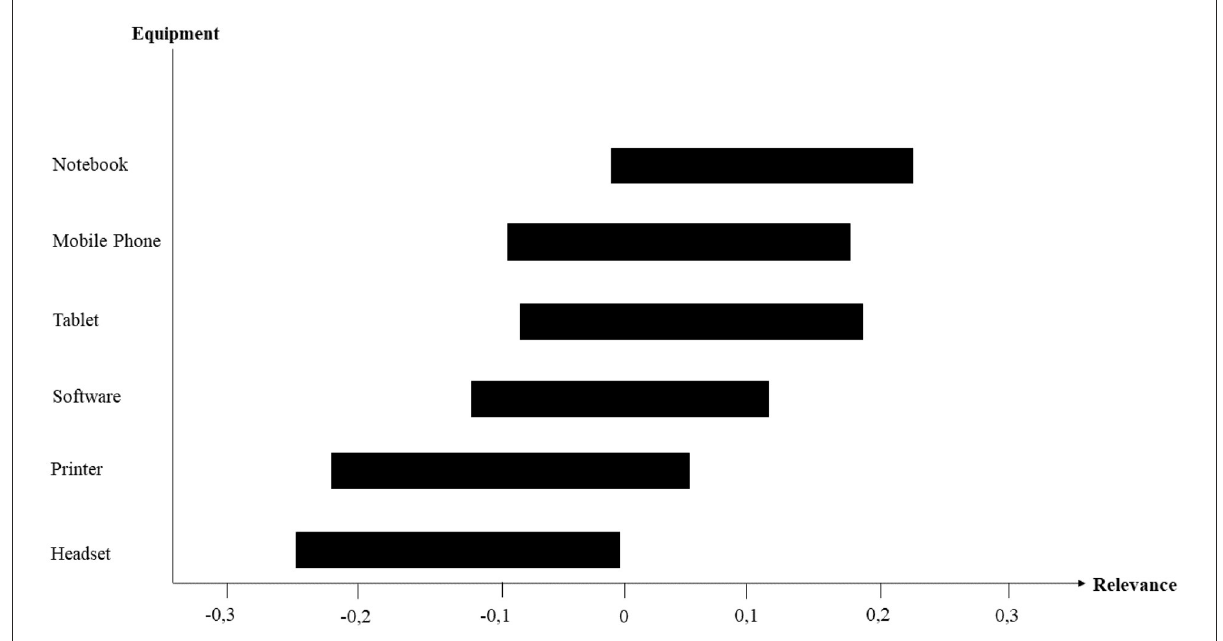
FIGURE4 Relevance of equipment that partially forms telework workplace